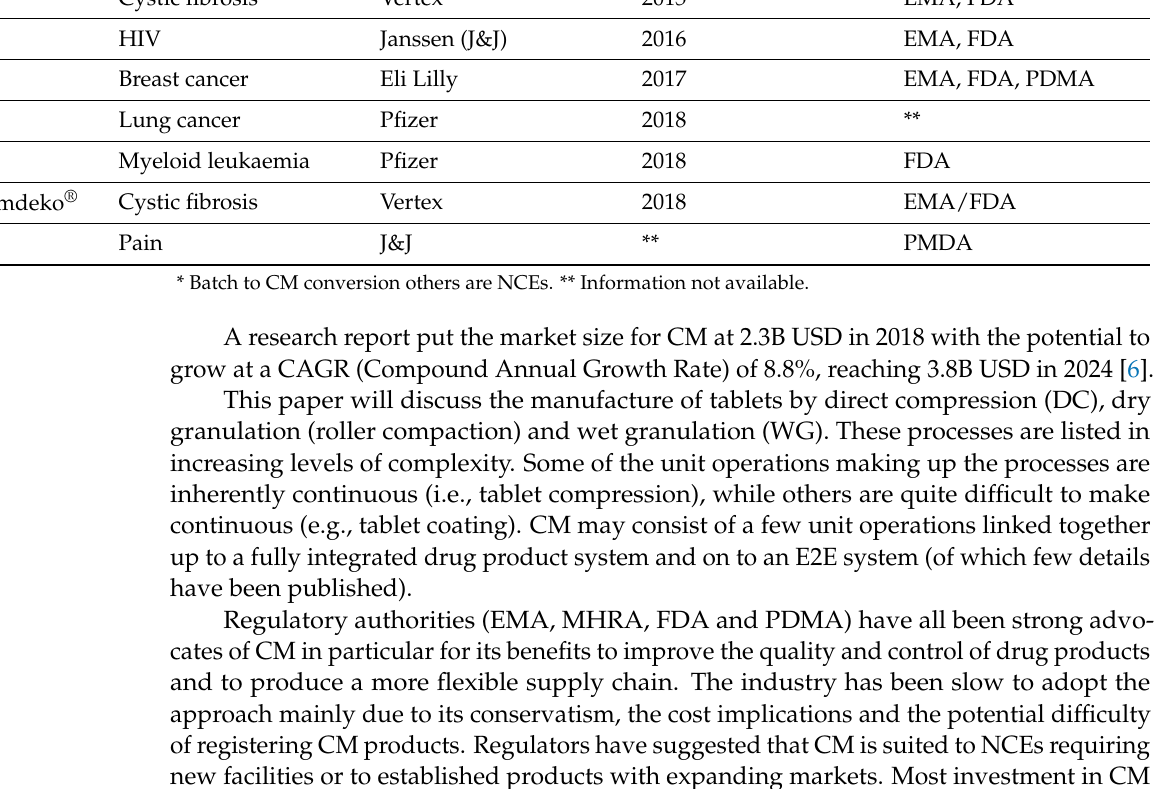
Figure 1. Schematic of a continuous manufacturing end-to-end (E2E) process compared to a traditional batch process. Adapted from [3], J. Pharm. Innov. 2015. Note: API manufacturing has traditionally occurred at a primary manufacturing site typically separate from the drug product site and often in a different (low-tax) country. Table 1. Approved drug products manufactured by continuous manufacturing (CM) Adapted from [4,5]. Drug Product